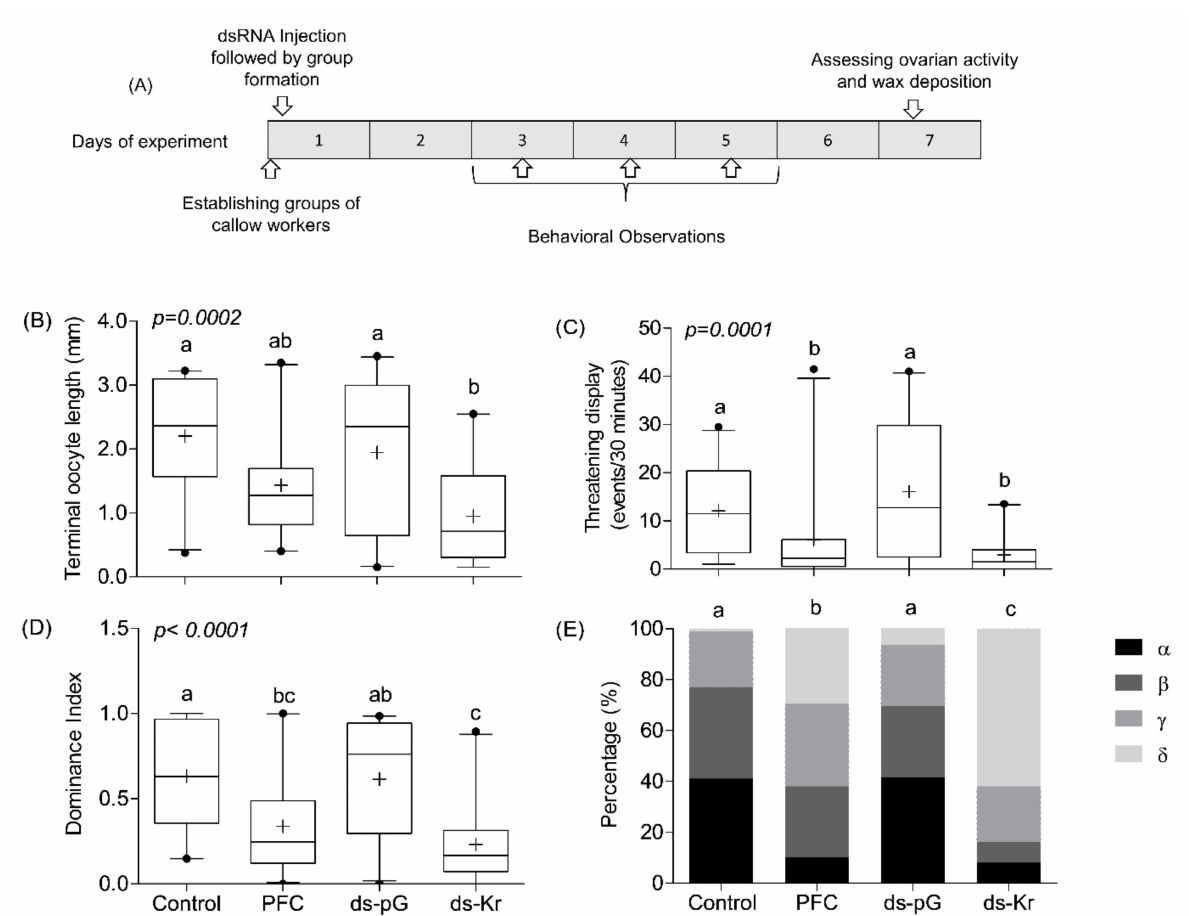
Figure 3. The influence of Kr-h1 down-regulation on dominance and aggression in mixed treatment groups. ( A ) Experimen- tal outline. ( B ) Ovarian activity at seven days of age. ( C ) Threatening displays. ( D ) Dominance index. ( E ) Proportion of dominance rank. The data shown in panel ( C – E ) are the average of the observations of days 3, 4, and 5; an overall similar pattern was obtained when each day was analyzed separately (Supplementary Figure S4). Treatments marked with different small letters in panels ( B – D ) are statistically different in a Kruskal–Wallis H test followed by Dunn’s post-hoc test, and in Chi square tests in panel ( E ) (see text for details). Sample size is n = 22 for all analyses. Further details are shown in Figure